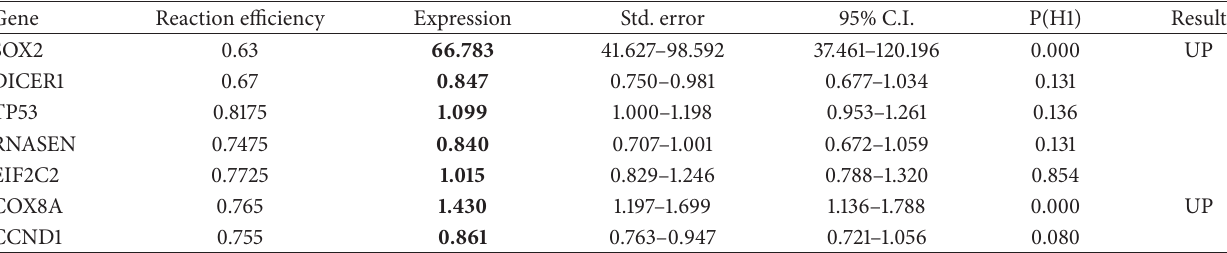
Table 7: Example of REST analysis on SOX2 and SOX2 ceRNAs levels of transcription quantified by RT-PCR compared to controls and normalized against 𝛽 -actin expression in SW1736 ATC cell line after SOX2 coding sequence (CDS) overexpression. P(H1) is the probability of the alternative hypothesis that the difference between sample and control groups is due only to chance.